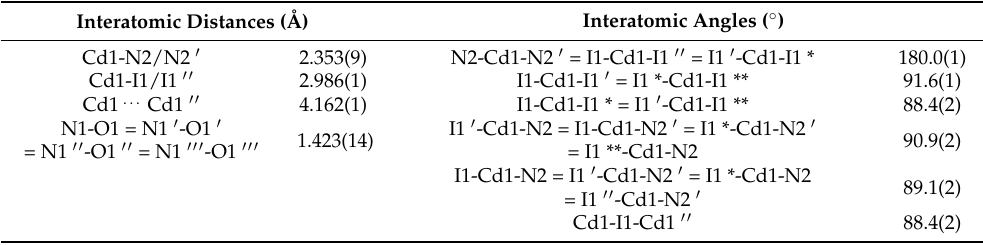
Table 3. Selected interatomic distances (Å) and angles ( ◦ ) for the polymeric compound {[CdI 2 (3paoH) 2 ]} n ( 2 ) a .